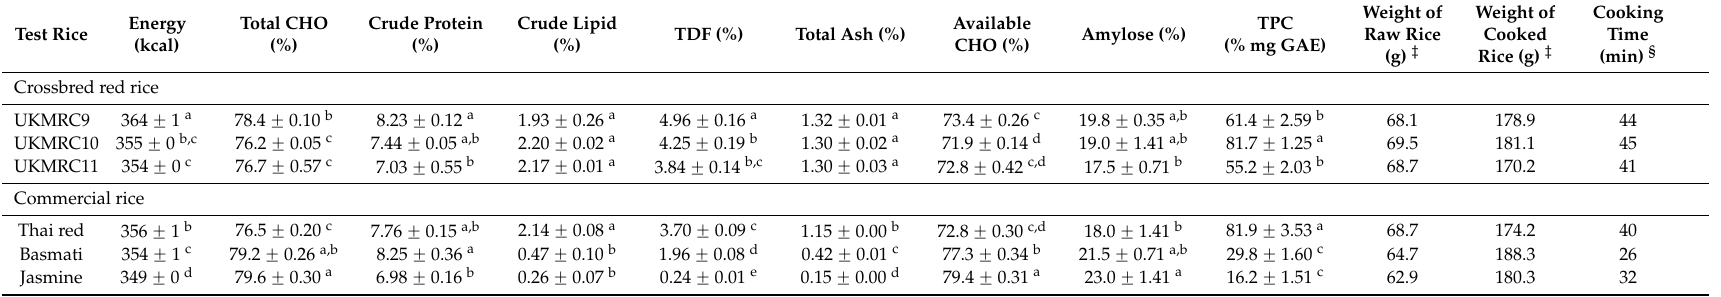
Table 1. Proximate nutrient composition (% by dry weight basis) † and cooking characteristics of test